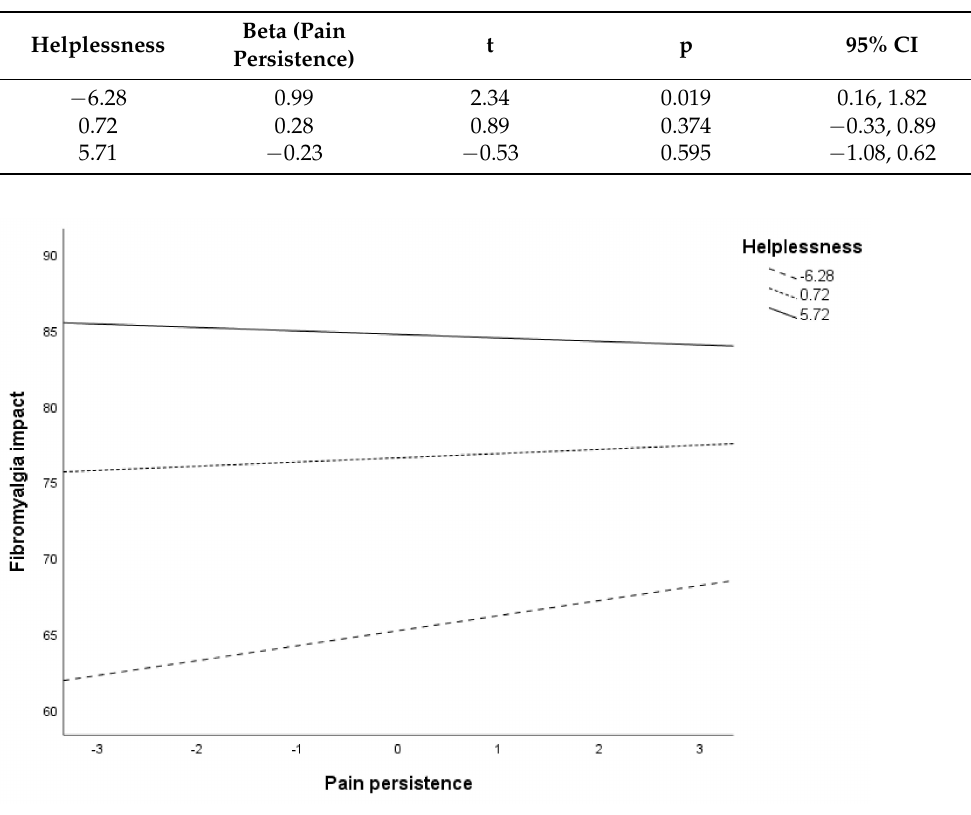
Table 7. Conditional effects of pain persistence on fibromyalgia impact at different values of helplessness.